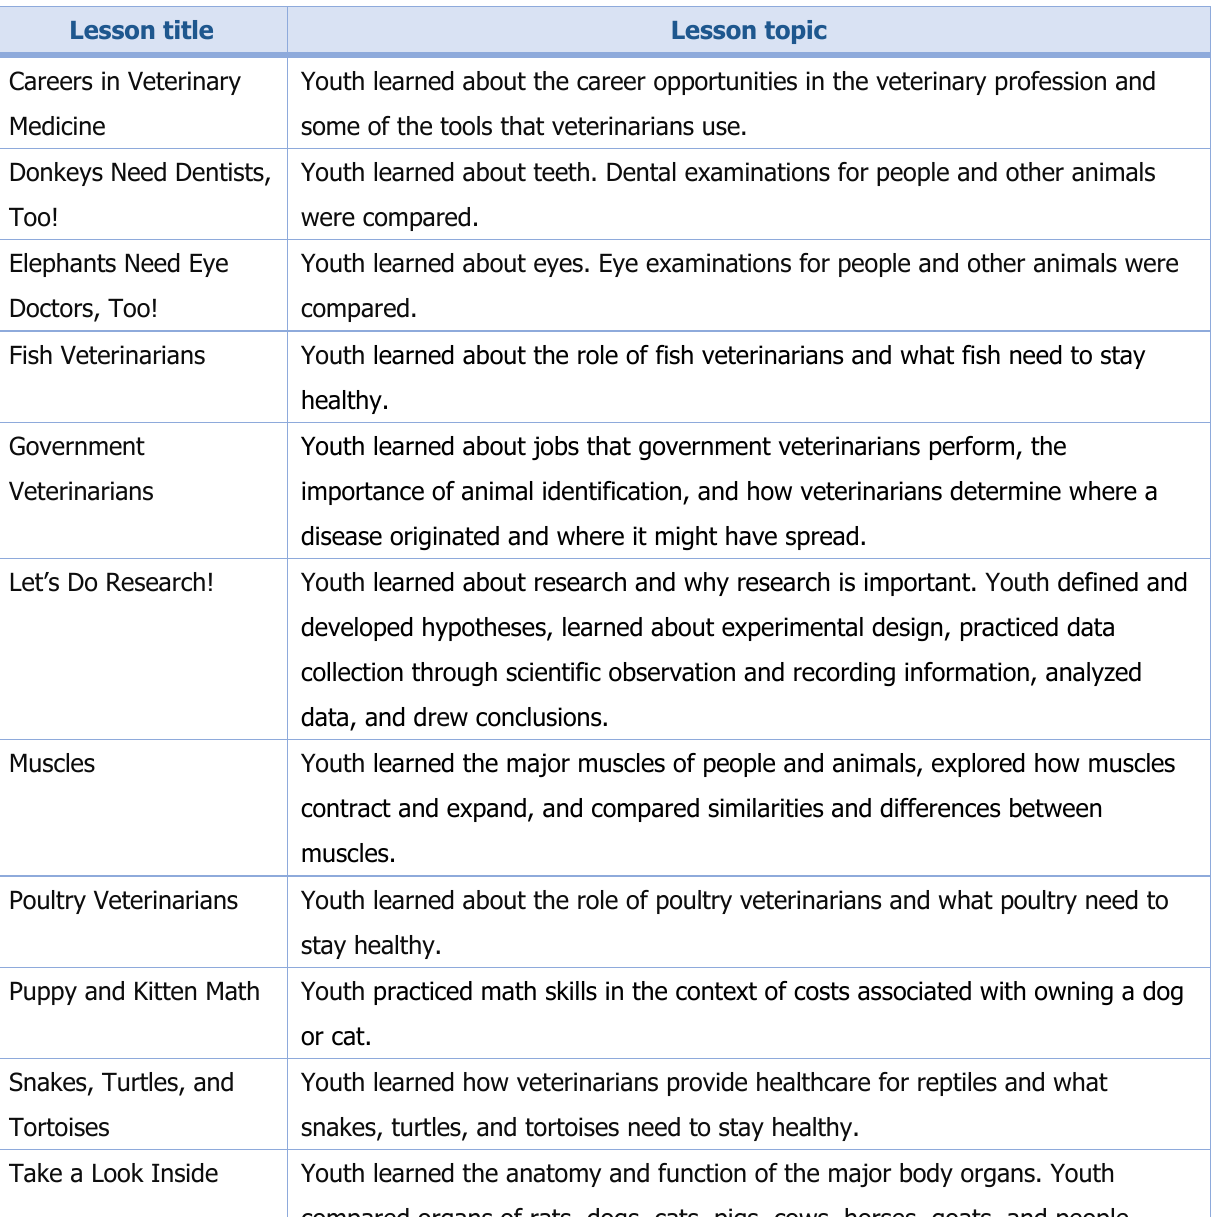
Table 2. Science Topics in Each Lesson Lesson title Lesson